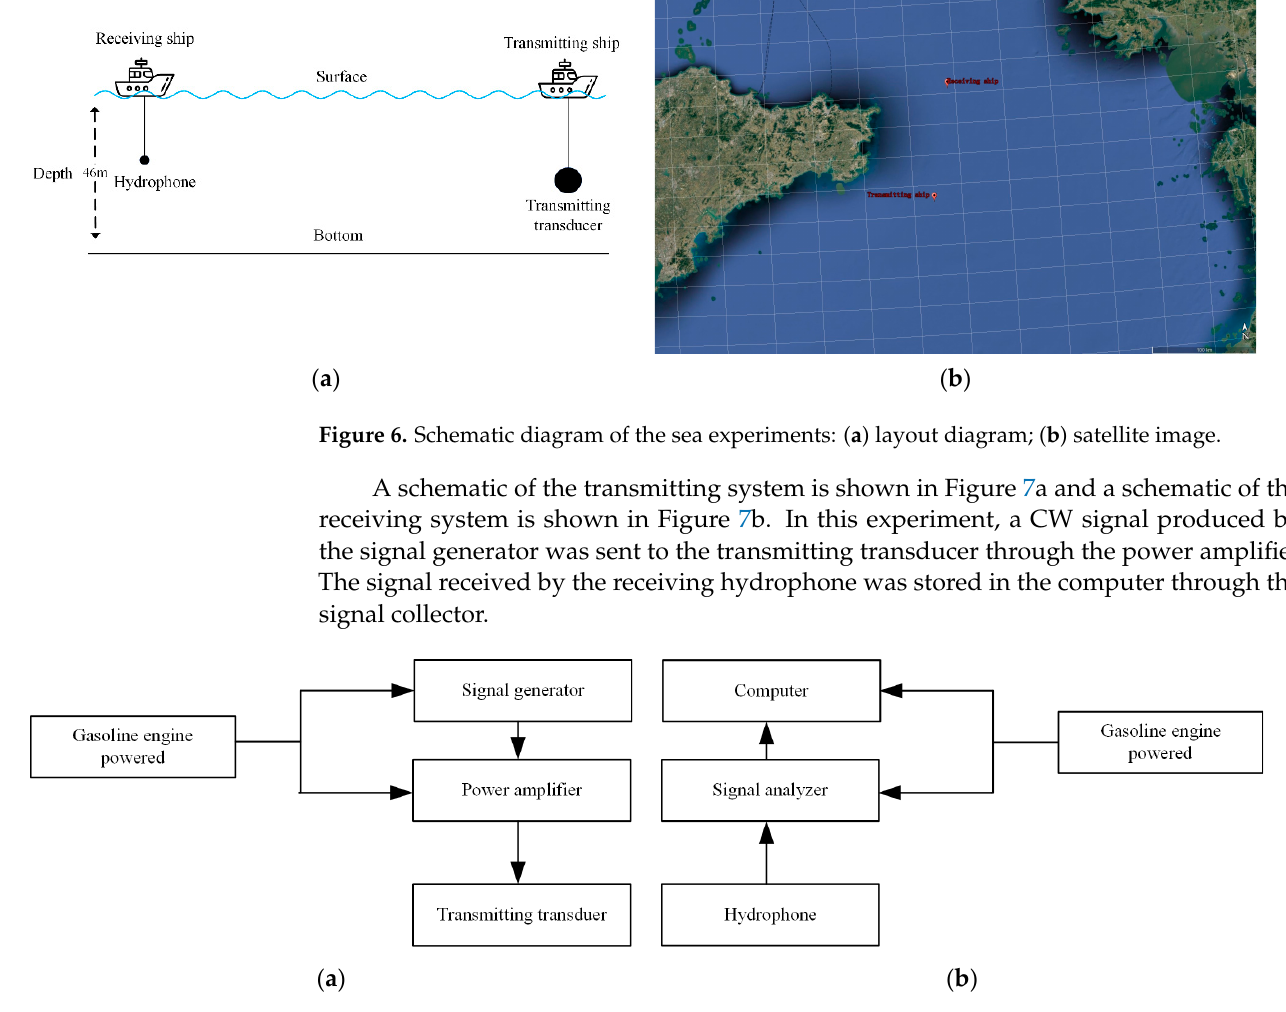
Figure 5. SHCS processing results with different overlap ratios: ( a ) coherence coefficient; ( b ) gain.